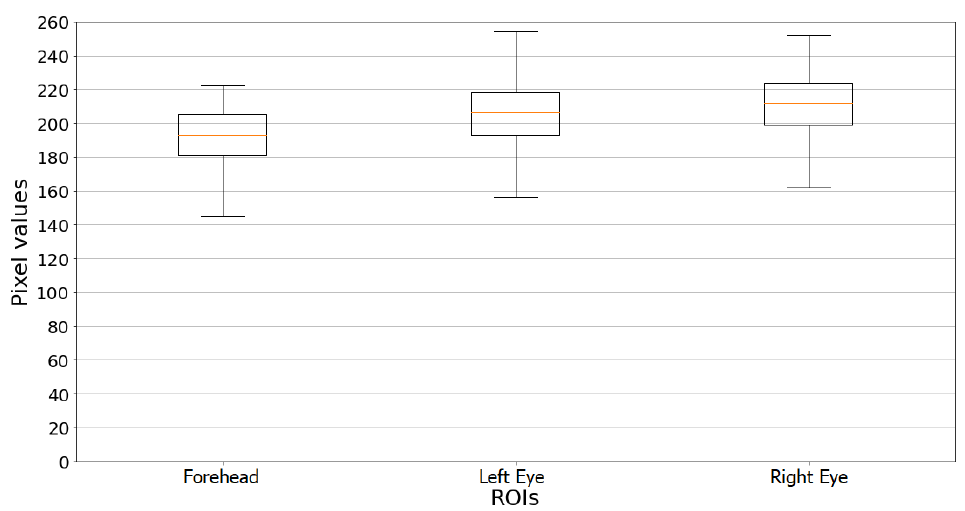
Figure 8. Extraction of ROIs to be analyzed.